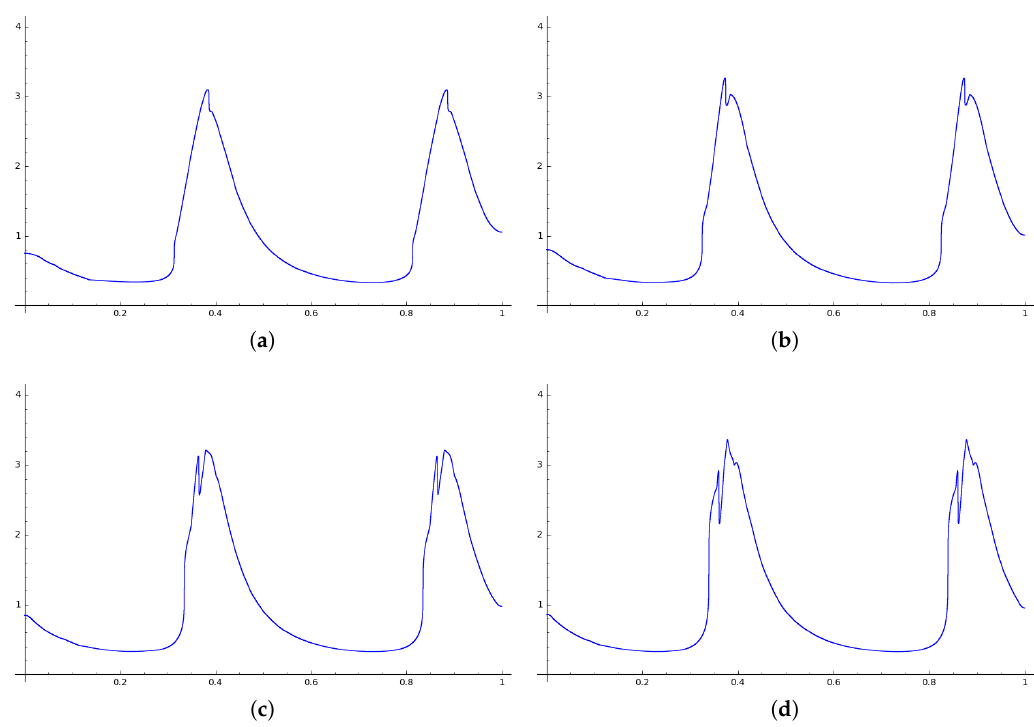
Figure 3. Approximated stationary densities f ξ , δ for T ξ , with δ = 2 − 19 and A = 0.08. ( a ) ξ = 0.732 × 10 − 1 ; ( b ) ξ = 0.488 × 10 − 1 ; ( c ) ξ = 0.305 × 10 − 1 ; ( d ) ξ = 0.214 × 10 − 1 .